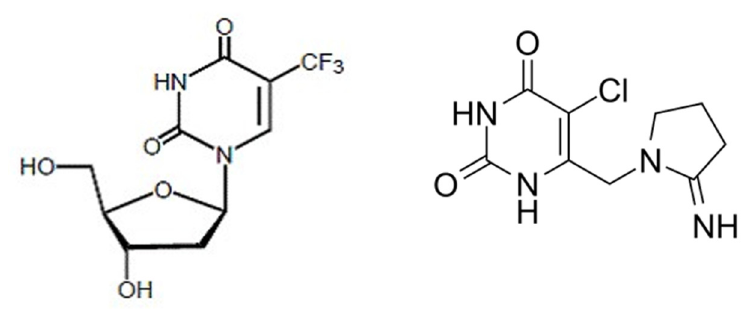
Figure 1. Chemical structures of the components of TAS 102: trifluridine on the left and tipiracil on the right.